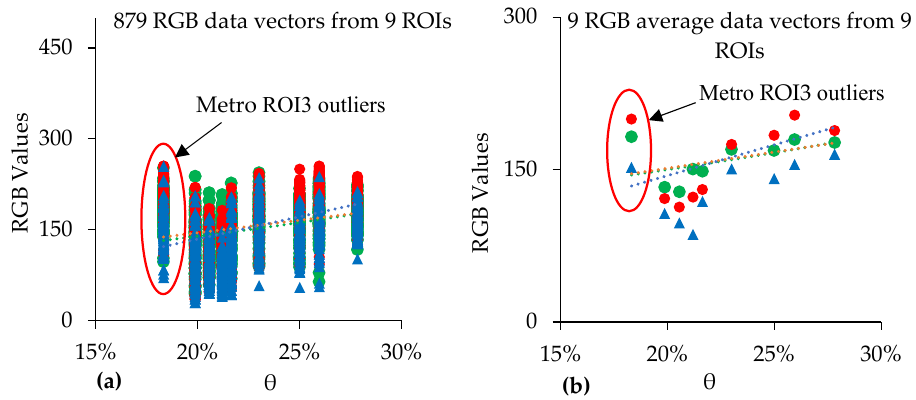
Figure 6. ( a ) RGB data vectors (all sites) variation with θ ( b ) RGB averages (all sites) variation with θ . The RGB average values variations with θ separated by the BG and VC classes are presented in Figure 7. Figure 7a represents the average RGB vs. θ for bare-ground ROIs, and Figure 7b represents average RGB values vs. θ for vegetation-covered ROIs. The red color is higher for the bare ground class, and the green color is higher for the vegetation-covered images, which is plausible. Furthermore, the near-surface soil moisture content was observed lower in vegetation-covered slope areas. In contrast, the near-surface θ was observed higher on bare-ground areas of the slope. This observation indicates that vegetation captures the soil moisture from the near-surface soil, resulting in lower near-surface.